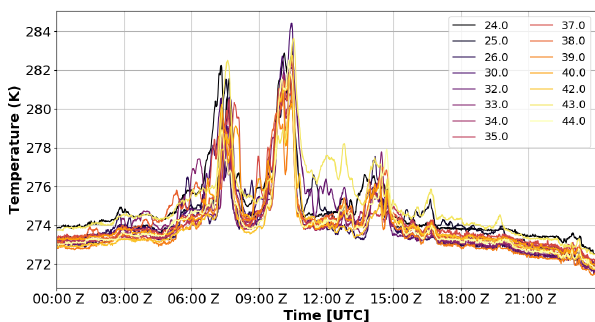
Figure 11. Time series of 1min averaged temperature for all sta- tions on 13 June